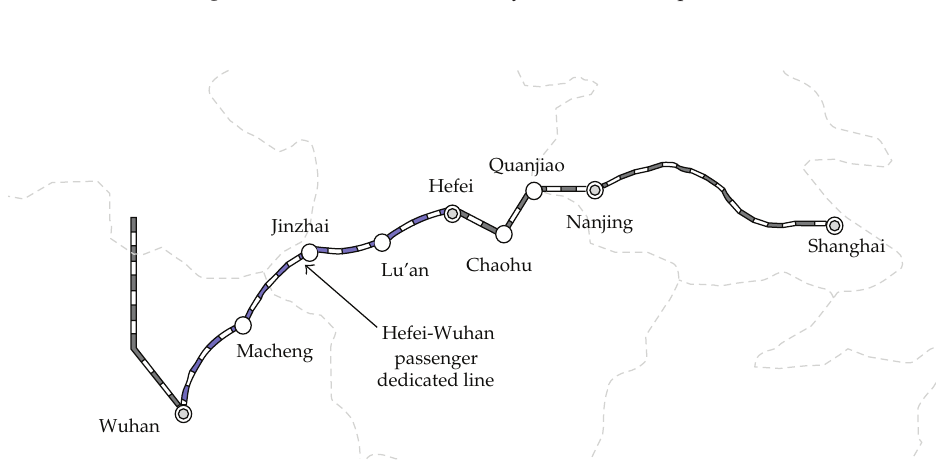
Figure 6: The illustration of Hefei-Wuhan intercity rail